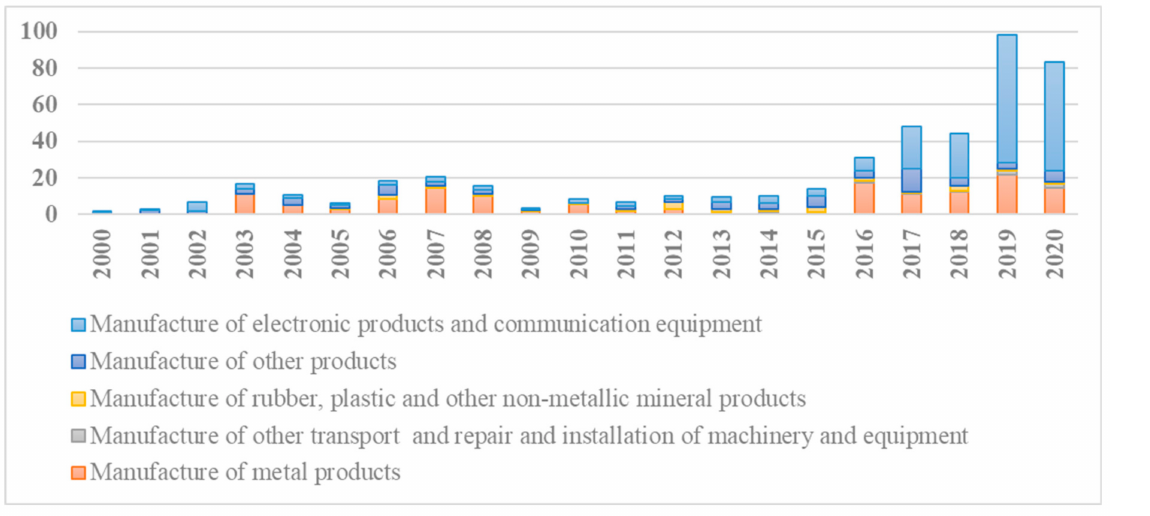
Figure 7. Investment by economic activity, million